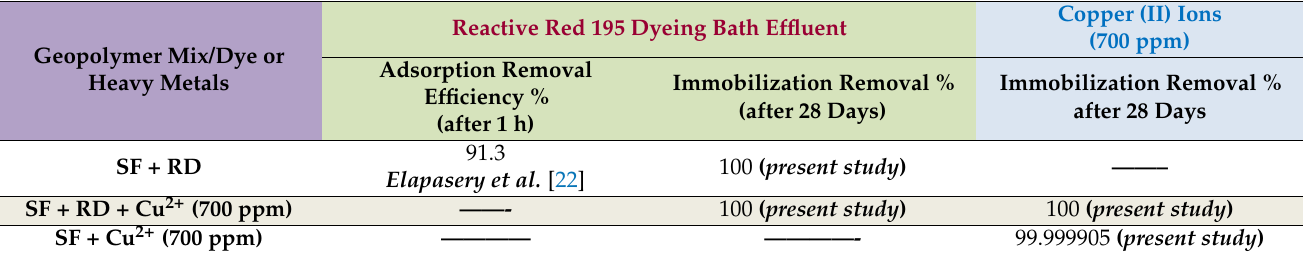
Table 7. Comparison between immobilization and adsorption removal % values for different haz- ardous materials by using slag/fly-ash-based geopolymer